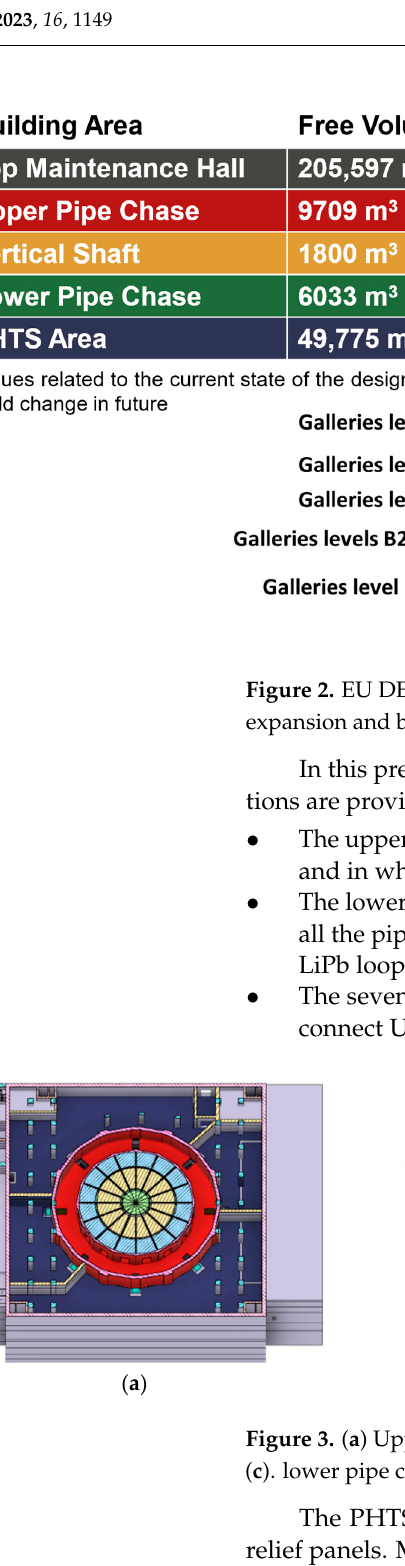
Figure 3. ( a ) Upper pipe chase (UPC) area in red and PHTS area in blue; ( b ) vertical shaft in yellow; ( c ). lower pipe chase in green.